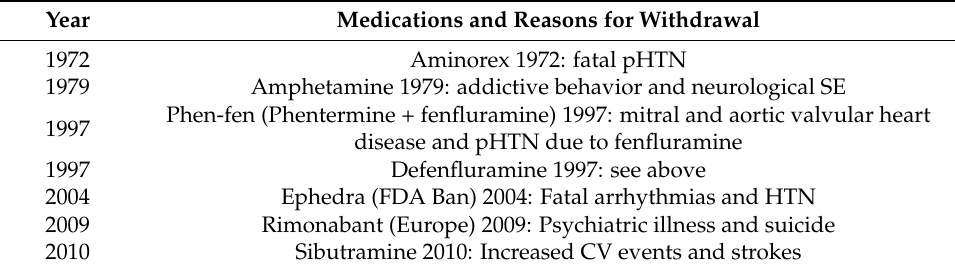
Table 2. Anti-obesity medications withdrawn from the